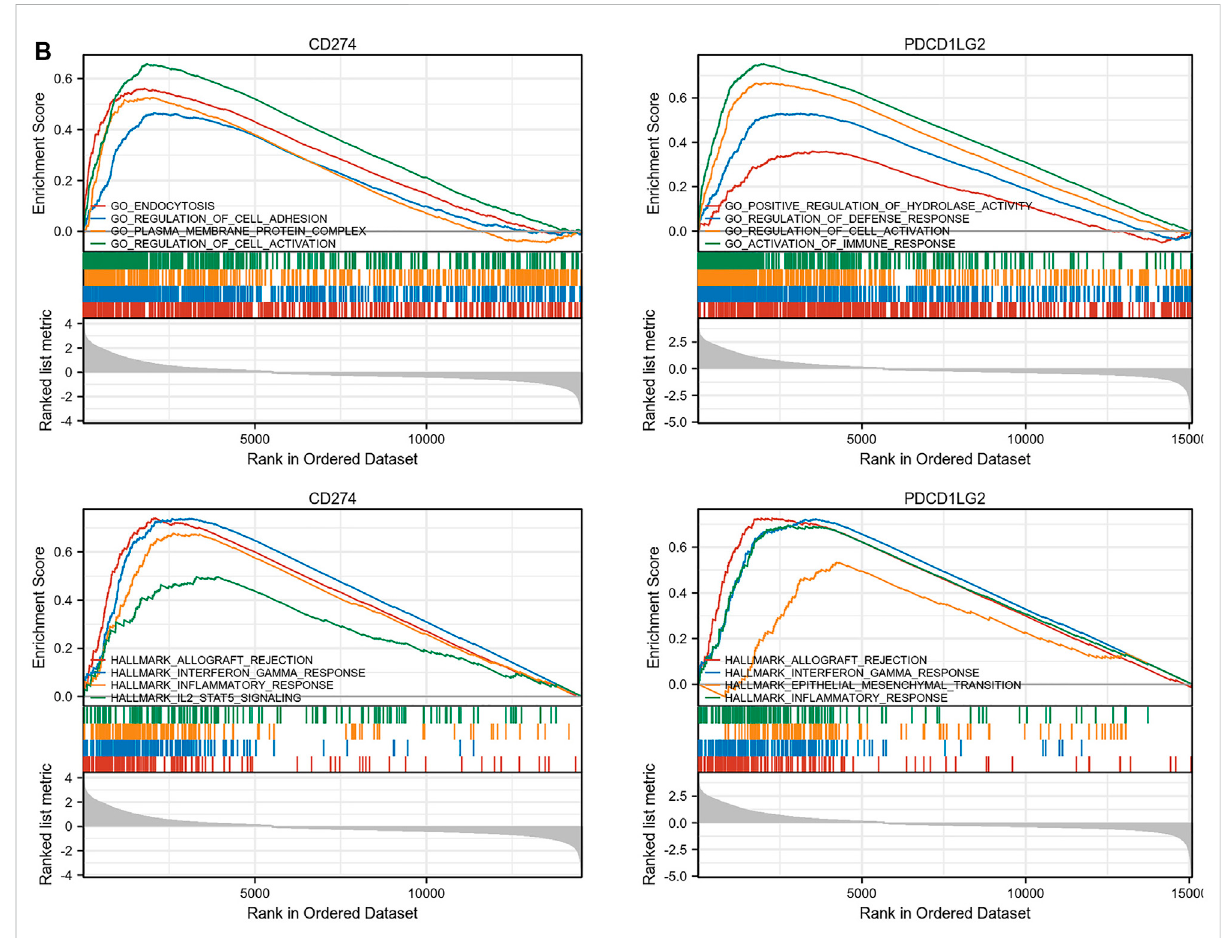
FIGURE 10 GSEAofCD274andPDCD1LG2inLGGandSKCM. (A) CD274andPDCD1LG2enrichedtopGOandHALLMARKpathwaysinLGG. (B) CD274and PDCD1LG2 were the top enriched GO and HALLMARK pathways in SKCM. The various colored curves indicate different functional pathways associated with CD274 and